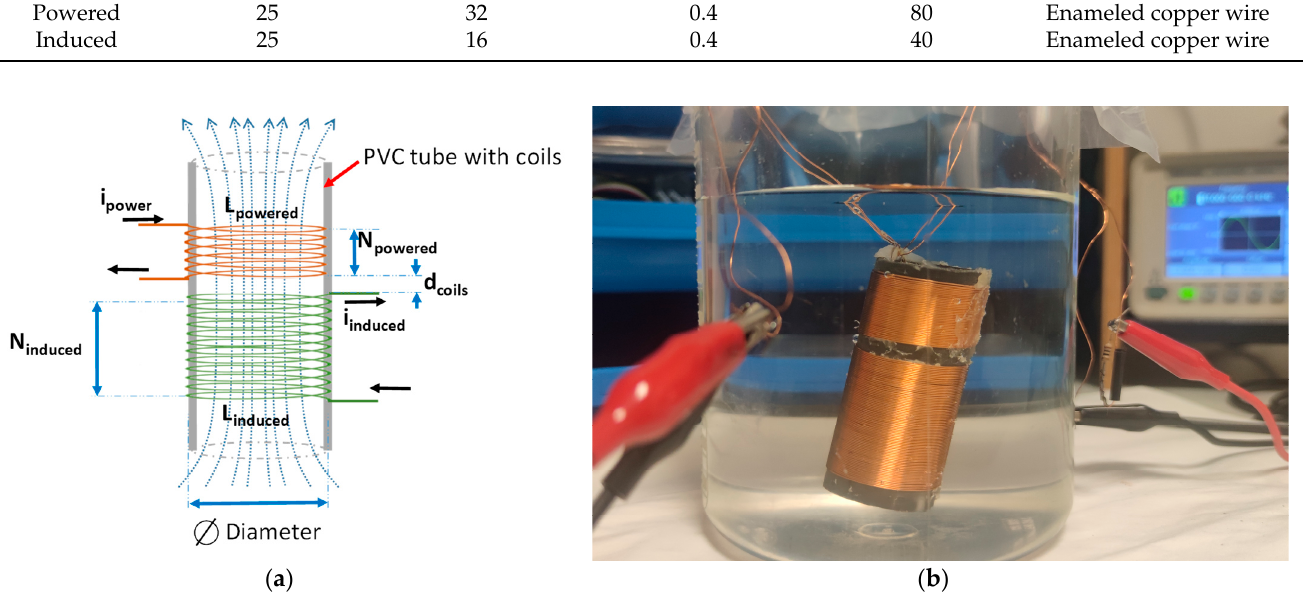
Figure 1. Sensor for pH measurement, ( a ) Diagram of the proposed system to measure the water pH, ( b ) Picture of the sensor.